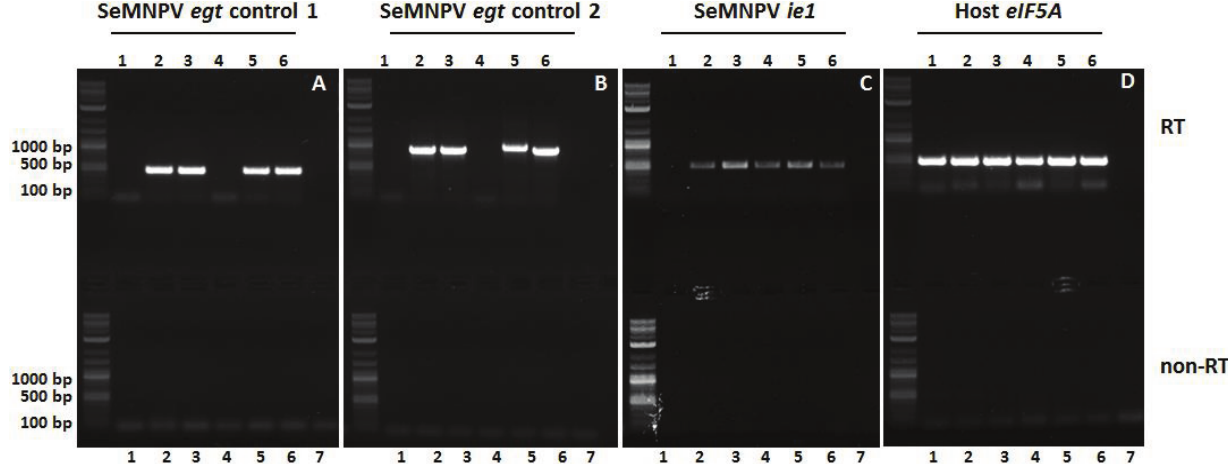
Figure 4. RT-PCR analysis of Spodoptera exigua larvae infected with WT, mutant and repair viruses. Larvae were mock-infected (1) or infected with G25 WT (2), SeBac10 WT (3), Δ egt - ORF (4), Δ egt -ATG (5) or egt -repair (6) viruses and processed for RT-PCR